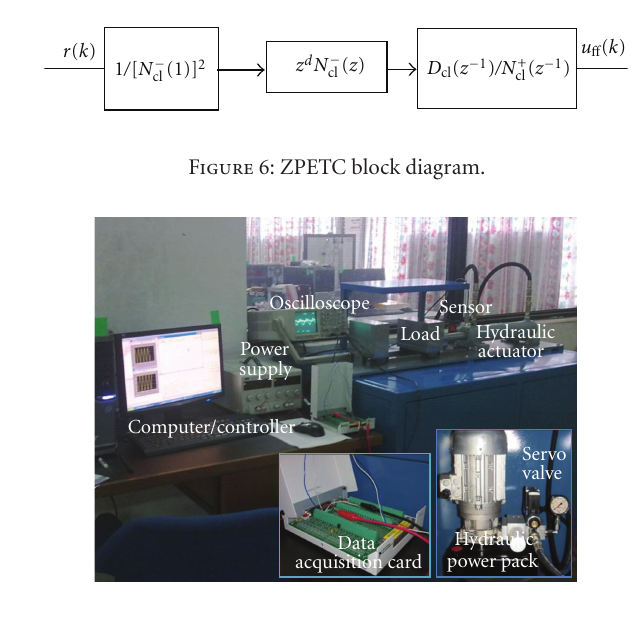
Figure 7: Experimental